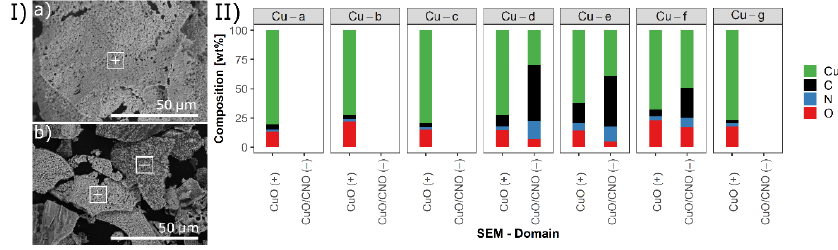
Figure 1. ( I ) SEM images of (a) Cu-b and (b) Cu-f. ( II ) Elemental composition (EDX) of synthesized copper catalysts Cu-a, Cu-b, Cu-c, Cu-d, Cu-e, Cu-f, and Cu-g. Varying the copper precursor also influences the morphology of the synthesized materials. Copper nanoparticles < 100 nm (Cu-a, Cu-b, Cu-d, Cu-e, Cu-f, and Cu-g) led to a frilled and compact structure with smooth surfaces (Cu-a in Figure 2a), while CuO < 50 nm as precursor led to larger pores and less dense ordered structure (Cu-c, Figure 2b). The different size of the used metal precursor particles may have affected the surface of the materials. Moreover, calcination at 500 °C may lead to sintering of the copper(II) oxide in Cu-c. In addition, the carbon-rich domains of the catalysts Cu-d, Cu-e, and Cu-f (CuO/CNO) show a similar smooth morphology compared to the Cu/CNO materials synthesized previously [21]. SEM images of all prepared catalysts are shown in Figure S3 in the Supplementary Material.